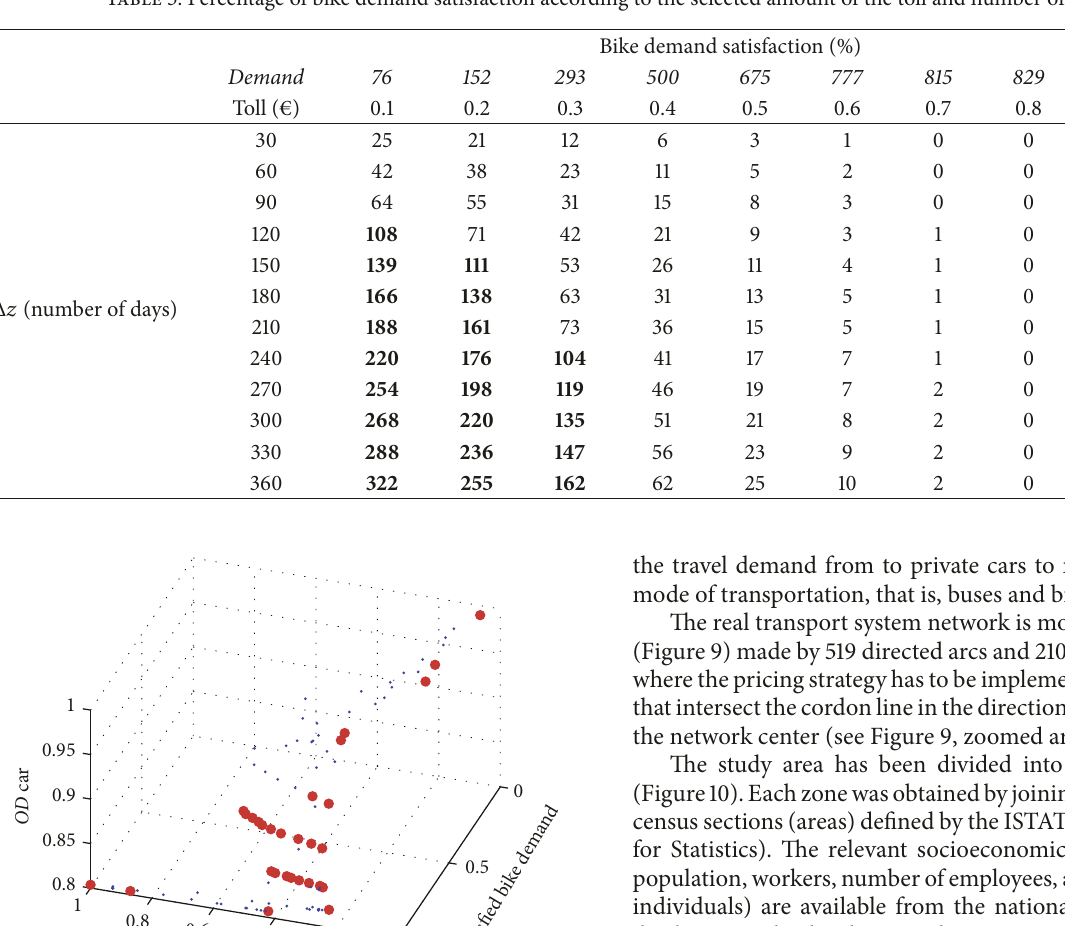
Table 5: Percentage of bike demand satisfaction according to the selected amount of the toll and number of days.